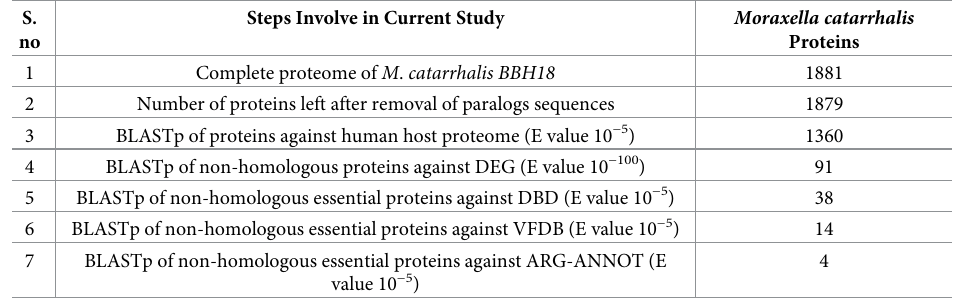
Table 1. Proteins clamp down in current study: Subtractive filtering of proteins from M . catarrhalis BBH18. S.